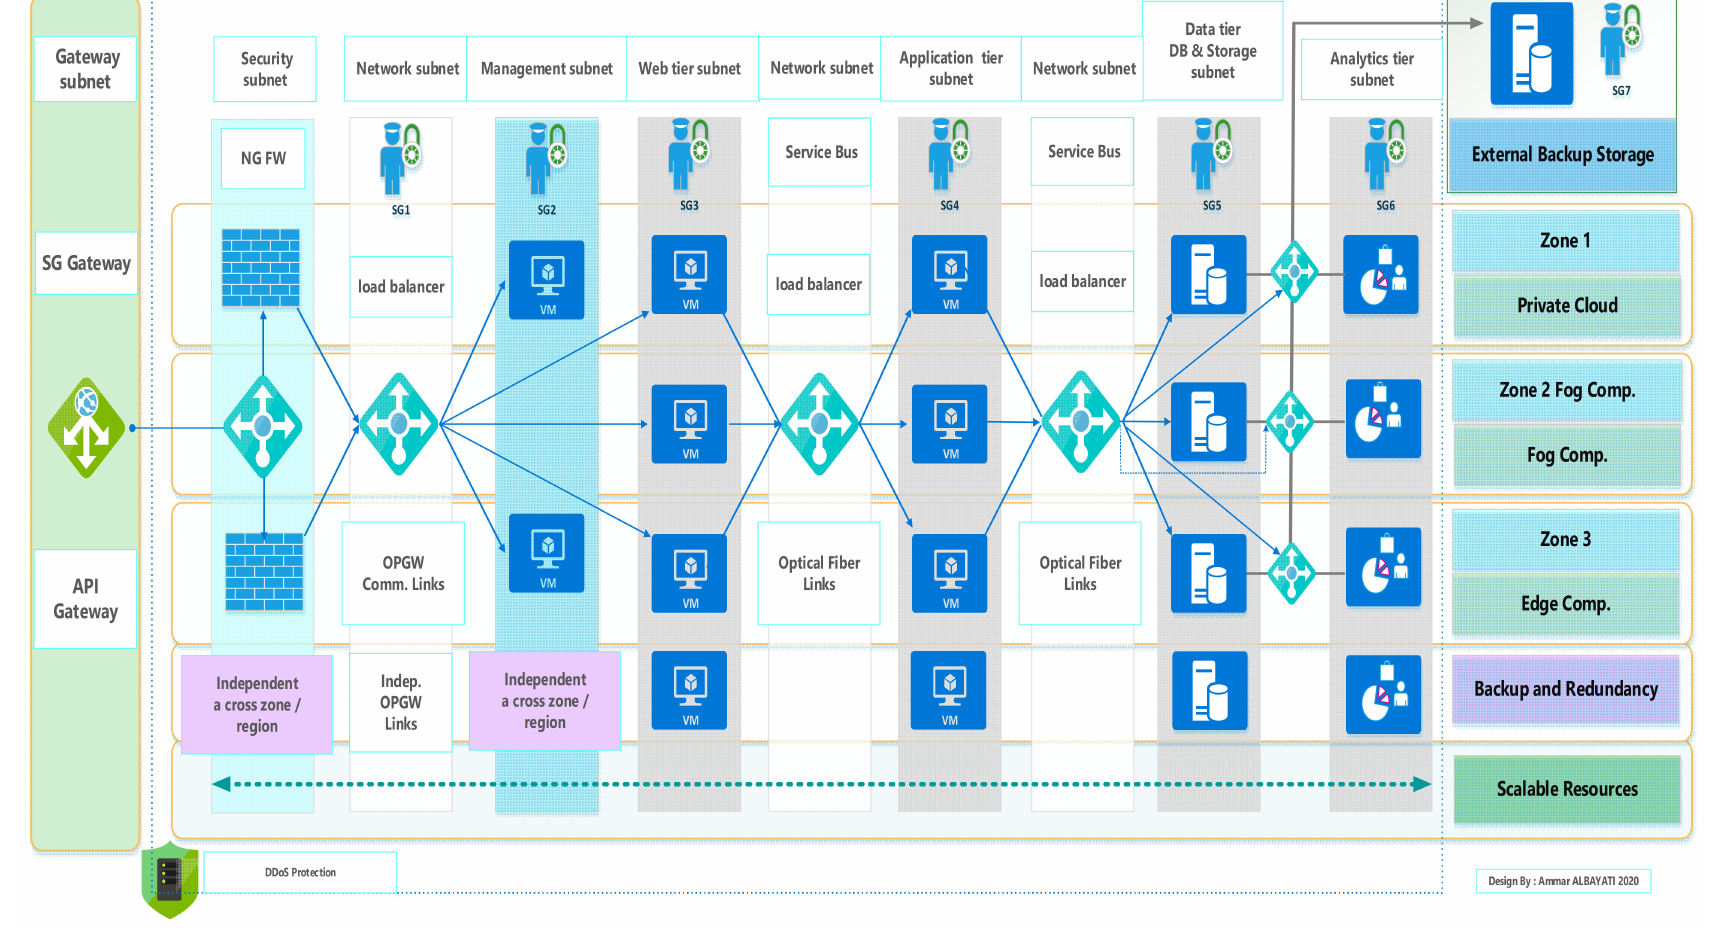
Figure 5. FC-EC SG-AMI proposed architecture